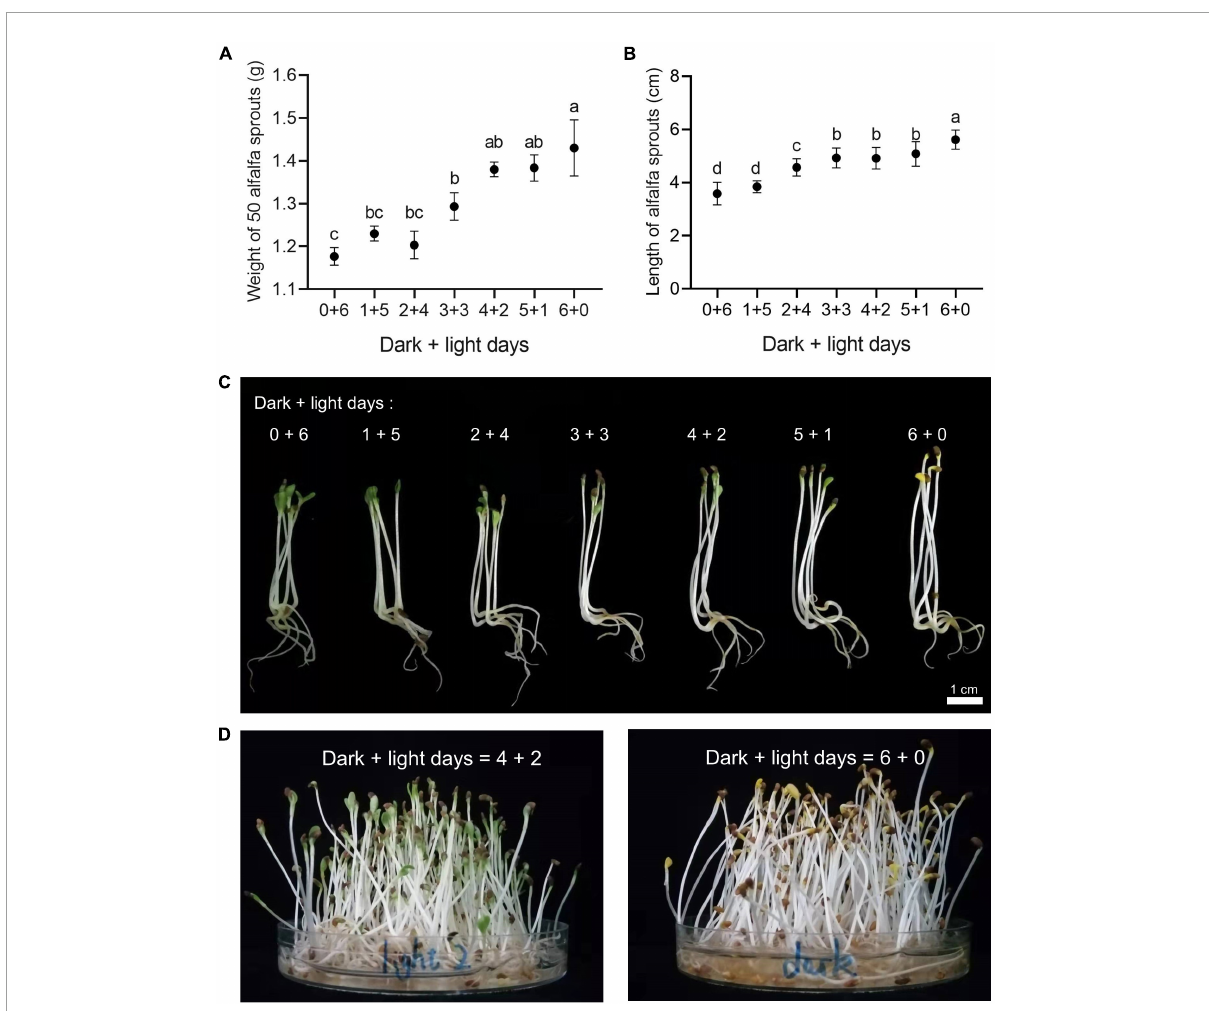
FIGURE1 Effects of different dark and light days on alfalfa sprout morphology in a 6-day germination cycle. (A) Effects of different dark and light days on the weight of 50 alfalfa sprouts in a 6-day germination cycle. Different letters indicate statistically significant differences generated by ANOVA using GraphPad Prism 8; values are expressed as mean ± SD, n = 50, P ≤ 0.05. (B) Effects of different dark and light days on the length of alfalfa sprouts (including hypocotyl and cotyledon parts) in a 6-day germination cycle. Different letters indicate statistically significant differences generated by ANOVA using GraphPad Prism 8; values are presented as mean ± SD, n = 50, P ≤ 0.05. (C) Effects of different dark and light days on the morphology of alfalfa sprouts. (D) Green alfalfa sprouts germinated in 4 days of darkness and 2 days of light and yellow alfalfa sprouts germinated in 6 days of darkness were the samples selected for subsequent